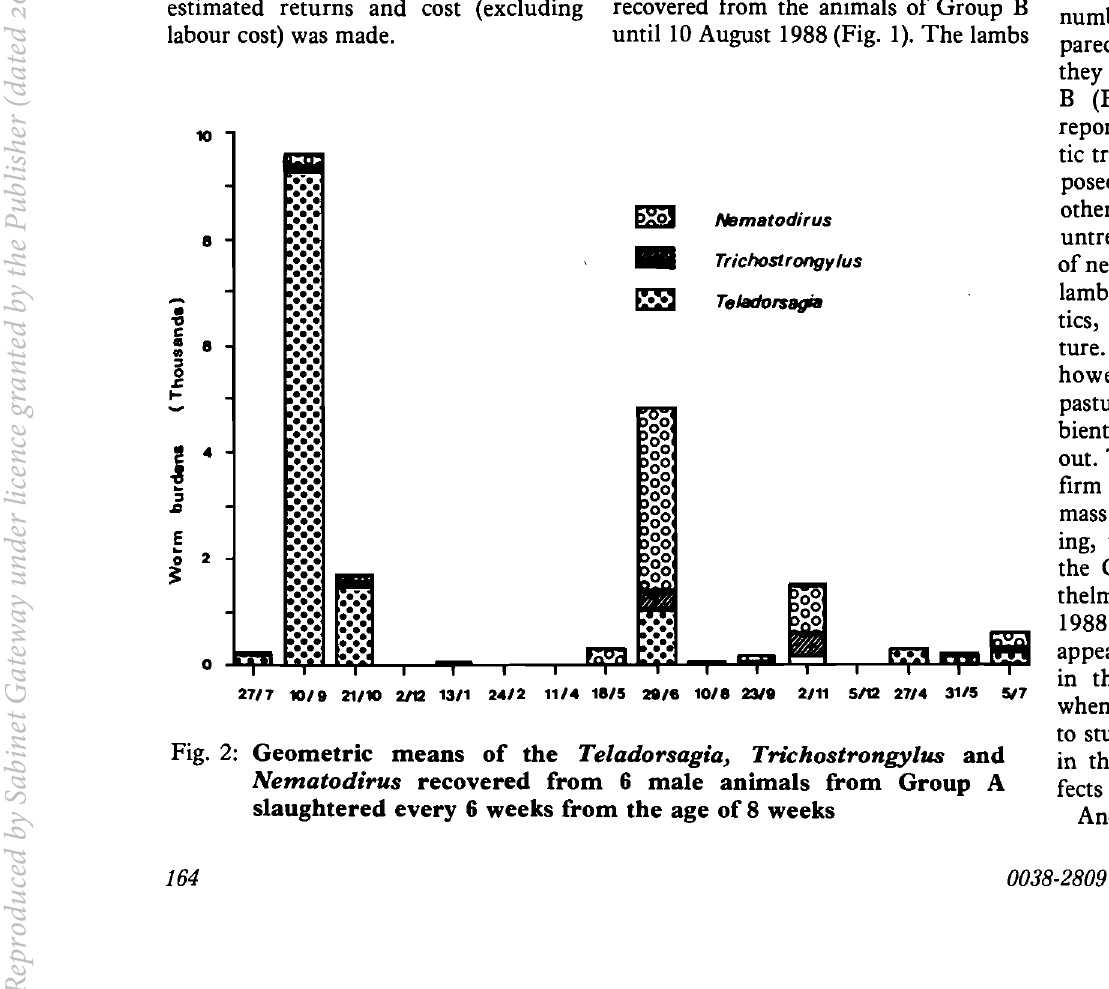
Fig. 2: Geometric means of the Teladorsagia, Trichostrongylus and Nematodirus recovered from 6 male animals from Group A slaughtered every 6 weeks from the age of 8